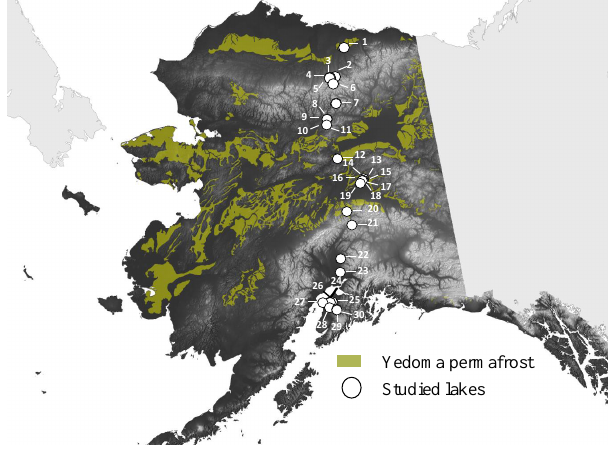
Figure 2. Locations of studied Alaskan lakes (white circles) plotted on the Alaska DEM hillshade raster. Information about the distri- bution of yedoma-type deposits (Pleistocene-aged, ice-rich silt con- taining deep thermokarst lakes) was from Jorgenson et al. (2008) and Kanevskiy et al. (2011). The Alaska map is the National Eleva- tion Data Set 30m hillshade